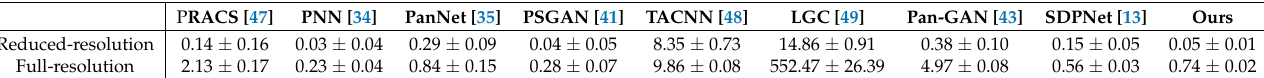
Table 5. Efficiency comparison of different methods on the test satellite images from the QuickBird data set. The mean and deviation values are shown in this table (unit: